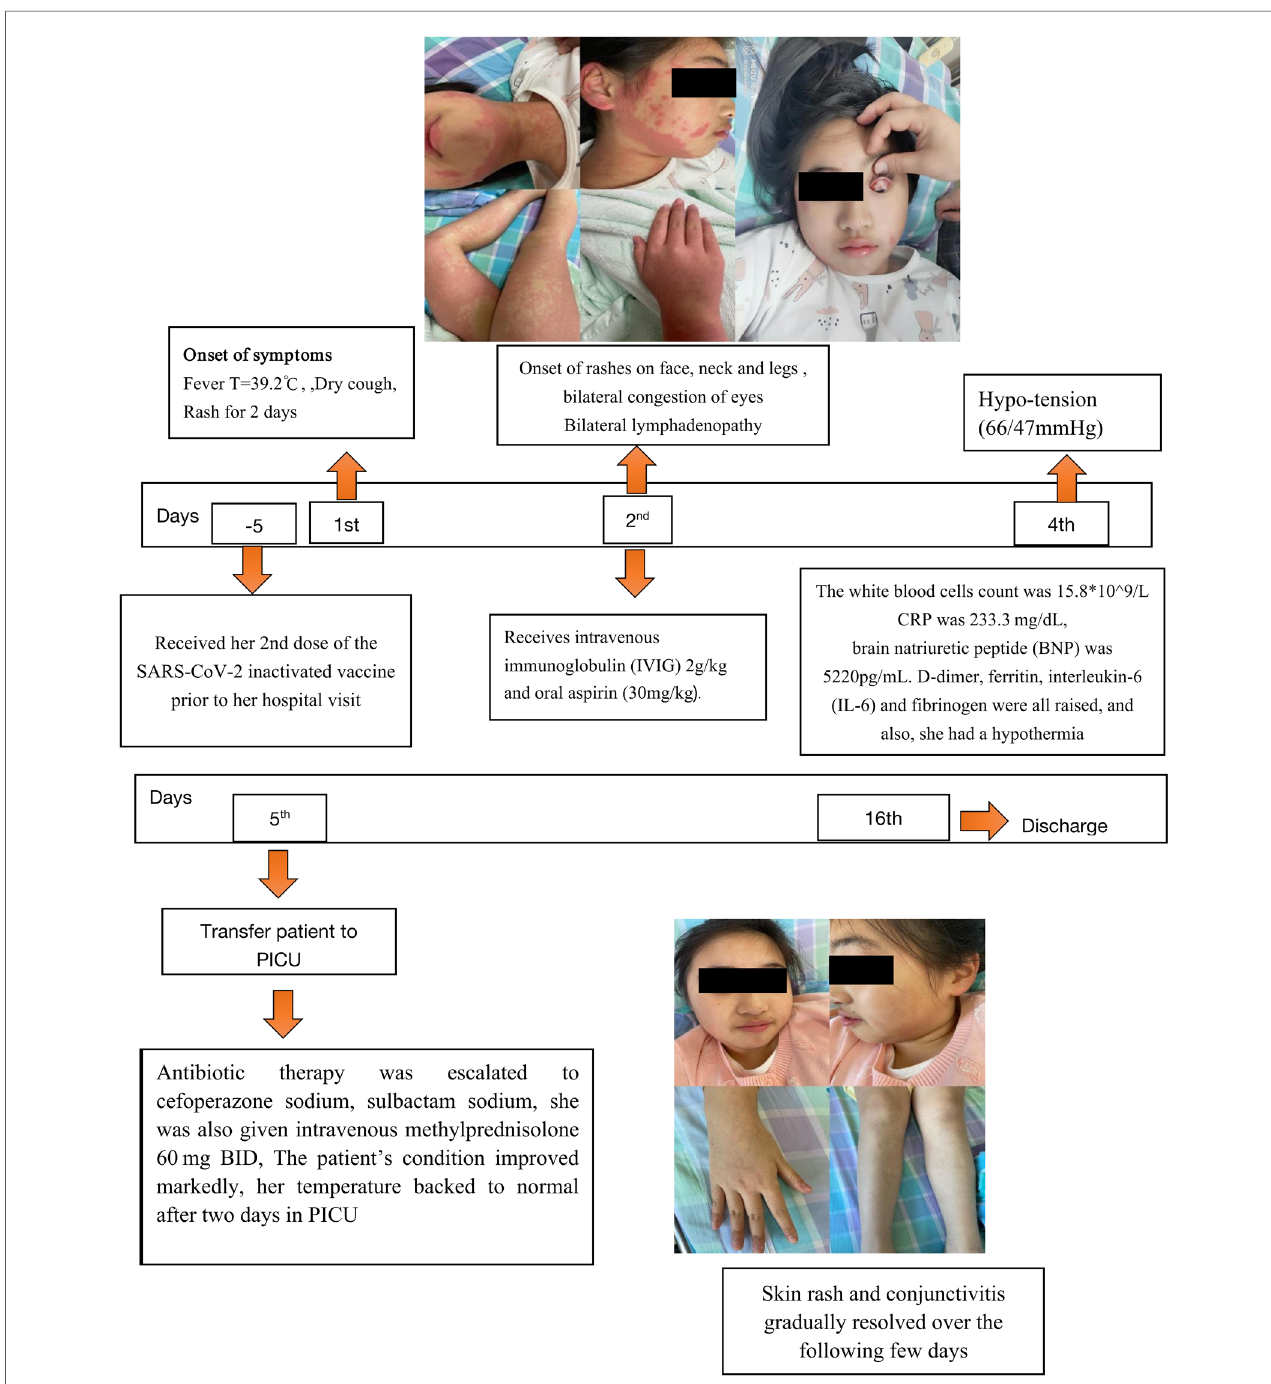
FIGURE 1 Timeline showing the clinical presentation and follow-up of the patient with multisystem in fl ammatory syndrome after COVID-19 vaccination. BNP, brain natriuretic peptide; CRP, C-reactive protein; IL-6, interleukin-6; PICU pediatric intensive care